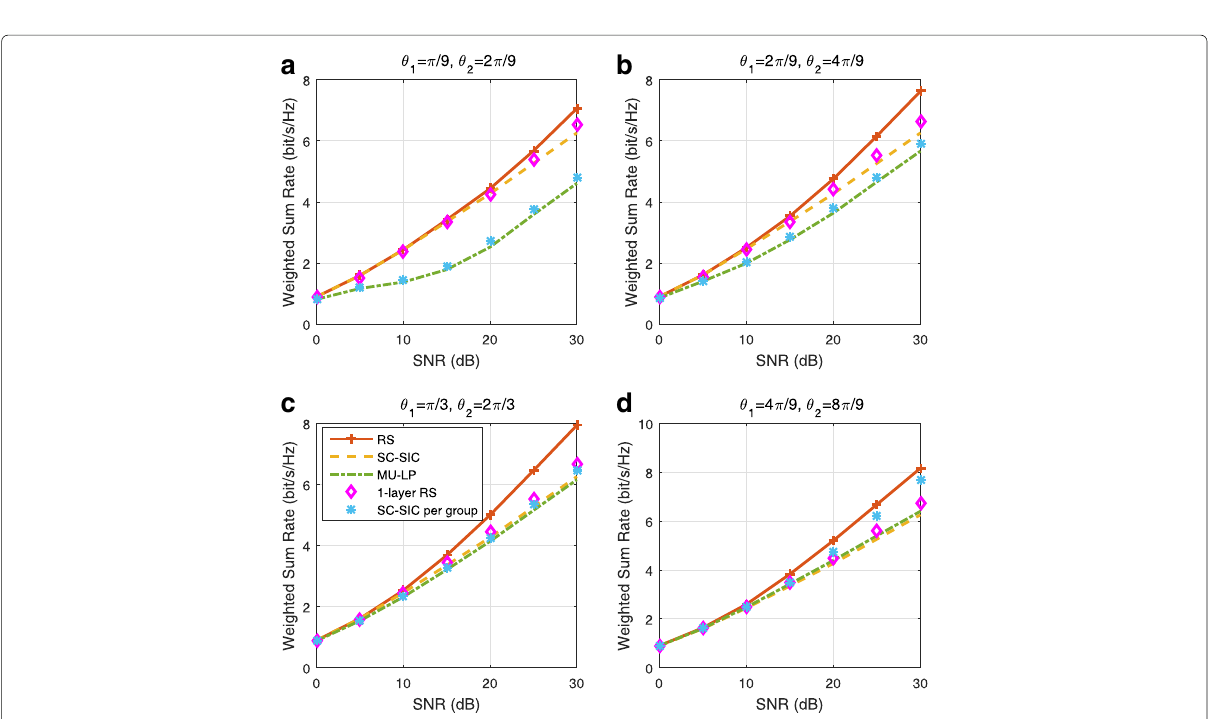
Fig. 43 Weighted sum rate versus SNR comparison of different strategies for overloaded three-user deployment with perfect CSIT, γ 1 = 1, γ 2 =